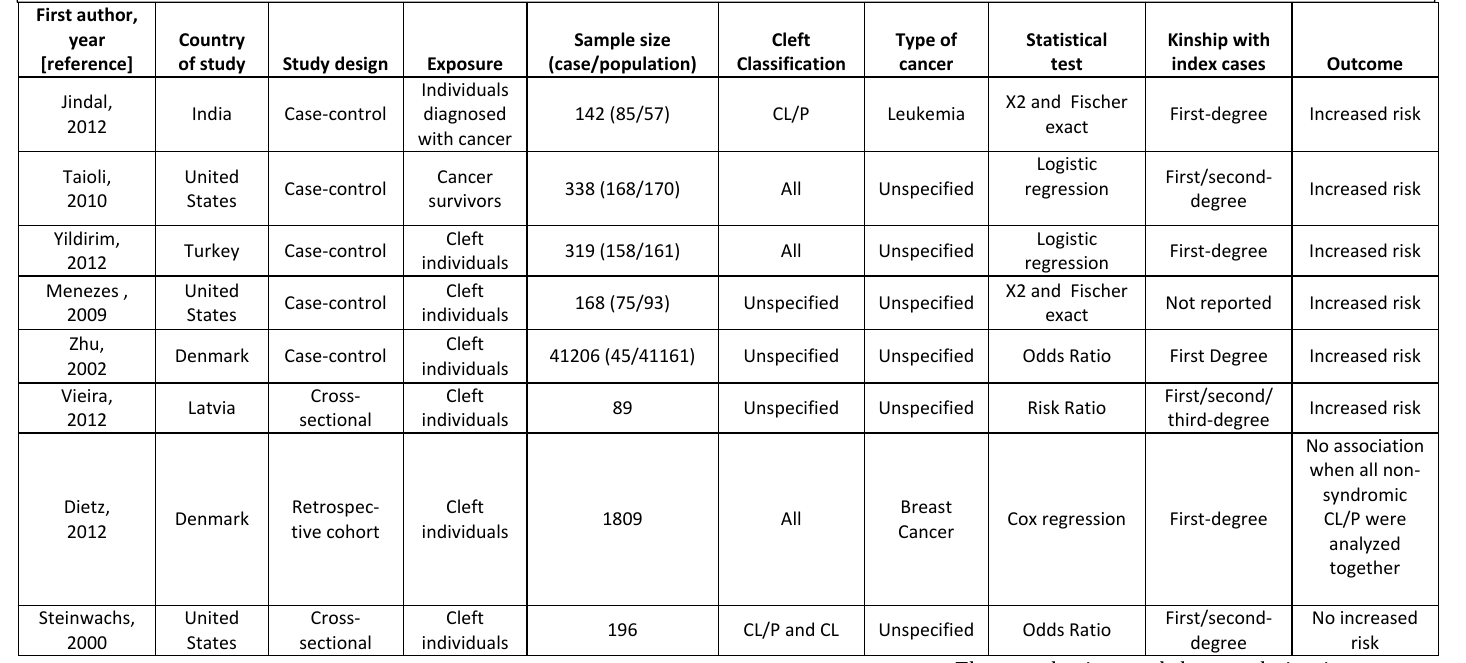
Table 1 : Main characteris (cid:415) cs of the eight selected